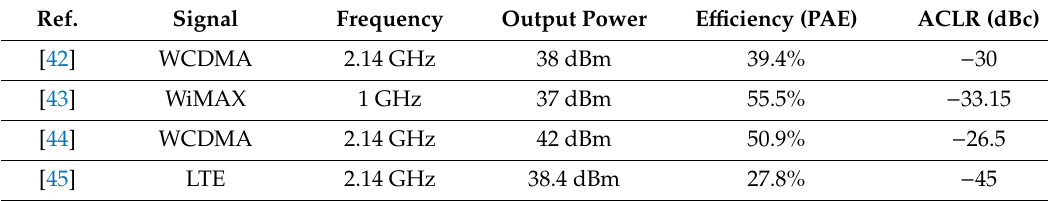
Table 4. Performance comparison of envelop tracking combined with Doherty amplifiers.